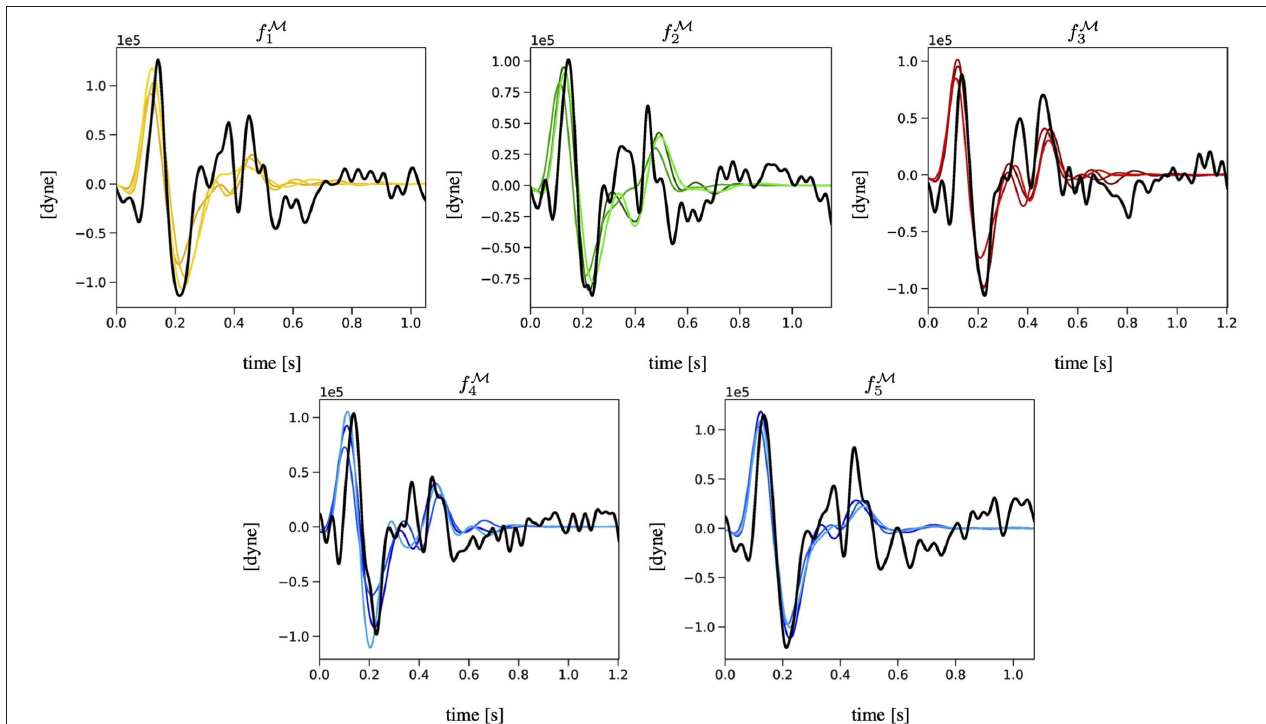
FIGURE 4 | Comparison among the BCG curves f M k , with k = 1, ... ,5 measured experimentally (in black) and the corresponding three best-ranked curves computed via the EA (in colors) for Subject 1.